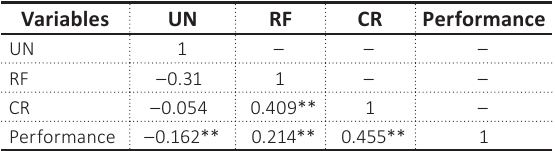
Table 2. Correlation results